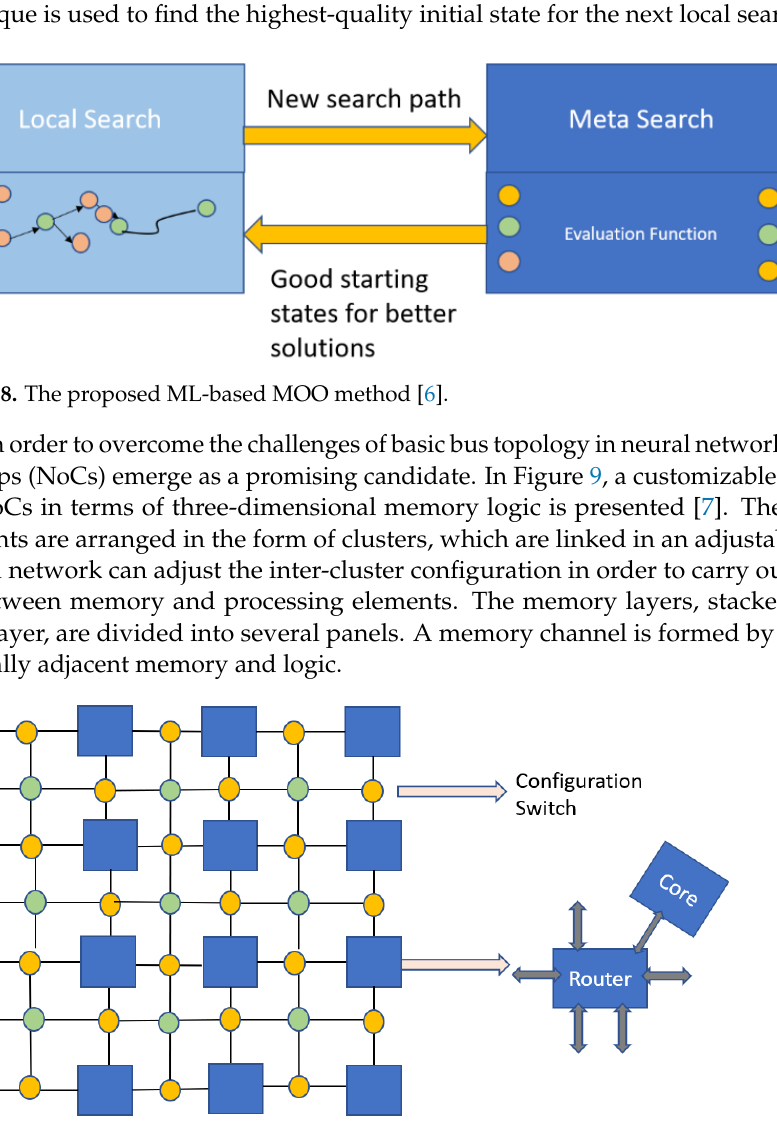
Figure 9. Arrangement of a reconfigurable NoC [7].